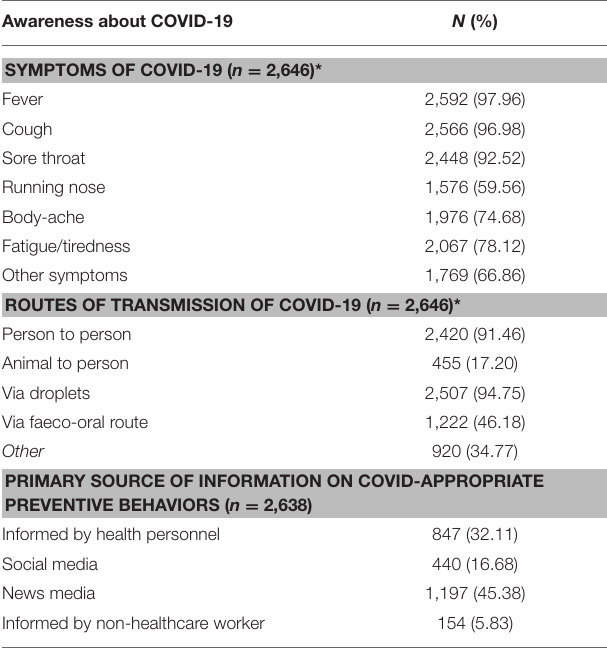
TABLE 2 | Awareness about symptoms and transmission of COVID-19 and information about preventive practices. Awareness about COVID-19 N (%) SYMPTOMS OF COVID-19 ( n = 2,646)*